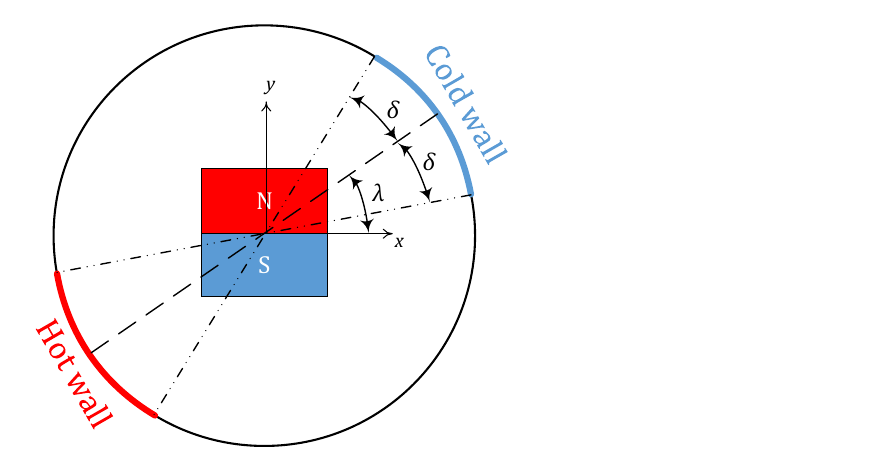
Figure 1. Computational domain along with the Cartesian coordinate system used in this study.